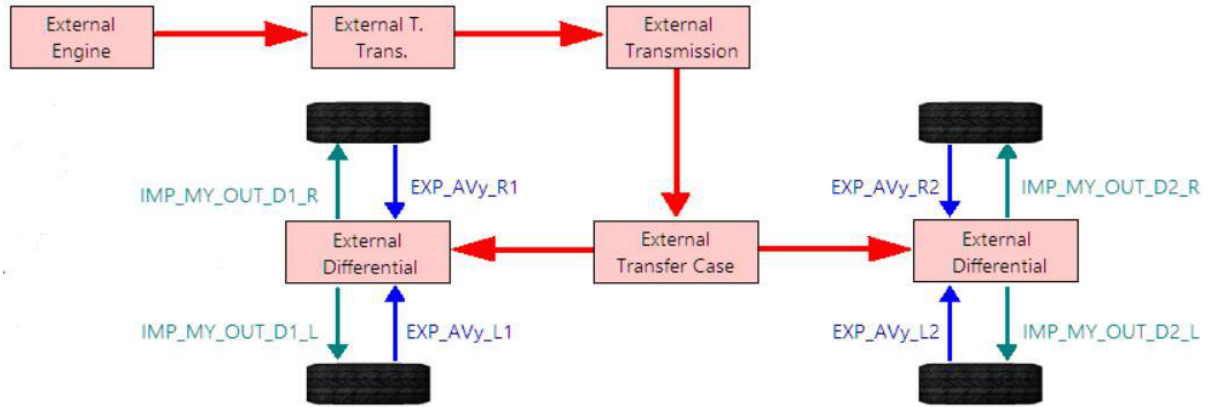
Figure 3. drive system. Figure 3. Drive